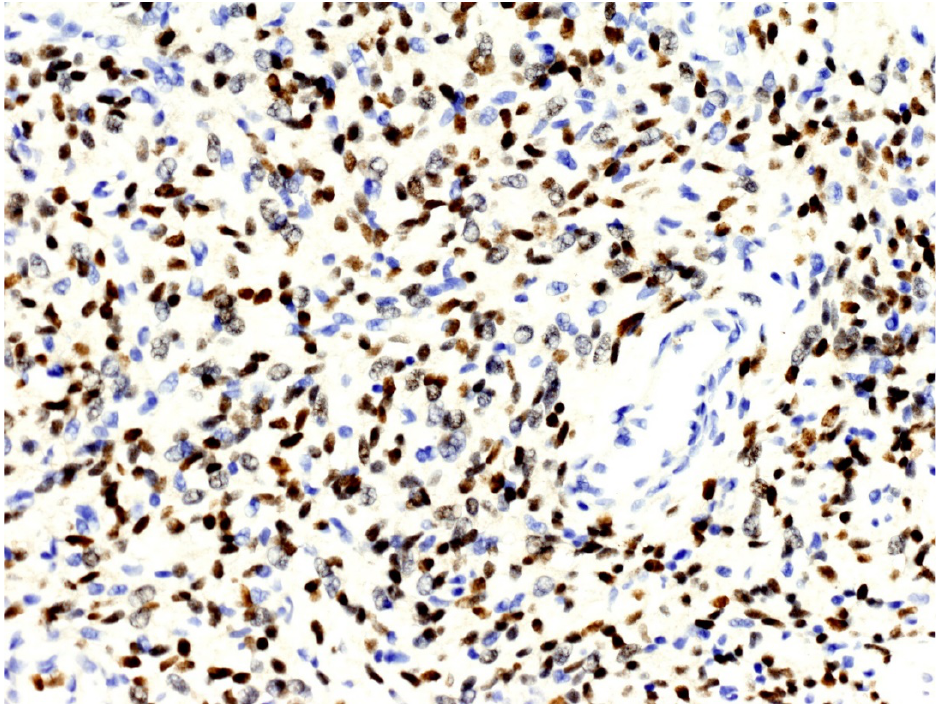
Figure 2. The nuclei of neoplastic cells express STAT6 (original magnification, ×200).